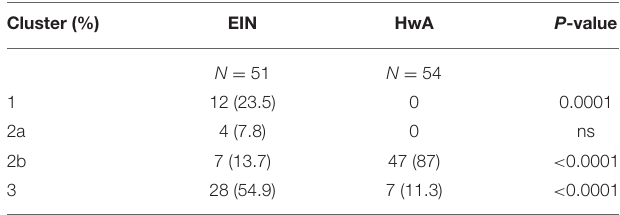
TABLE 4 | Evaluation of each cluster based on classification using WHO and EIN